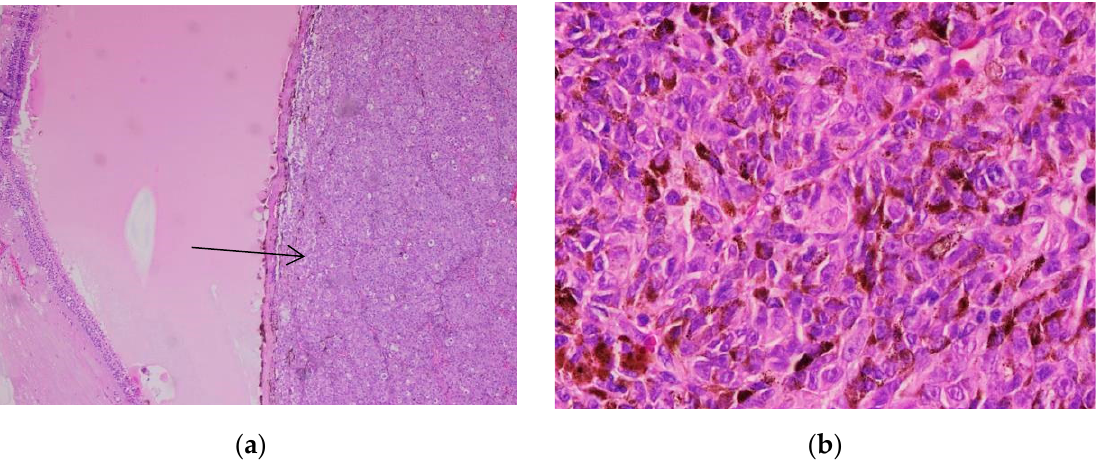
Figure 9. Uveal melanoma. ( a ) Solid tumor proliferation, 10x magnification. ( b ) Cytological features are seen (pleomorphic, enlarged nuclei with prominent nucleoli). Melanin pigment is observed. 40× magnification. (Collection of Pathology Department SCJ Mure ș ).